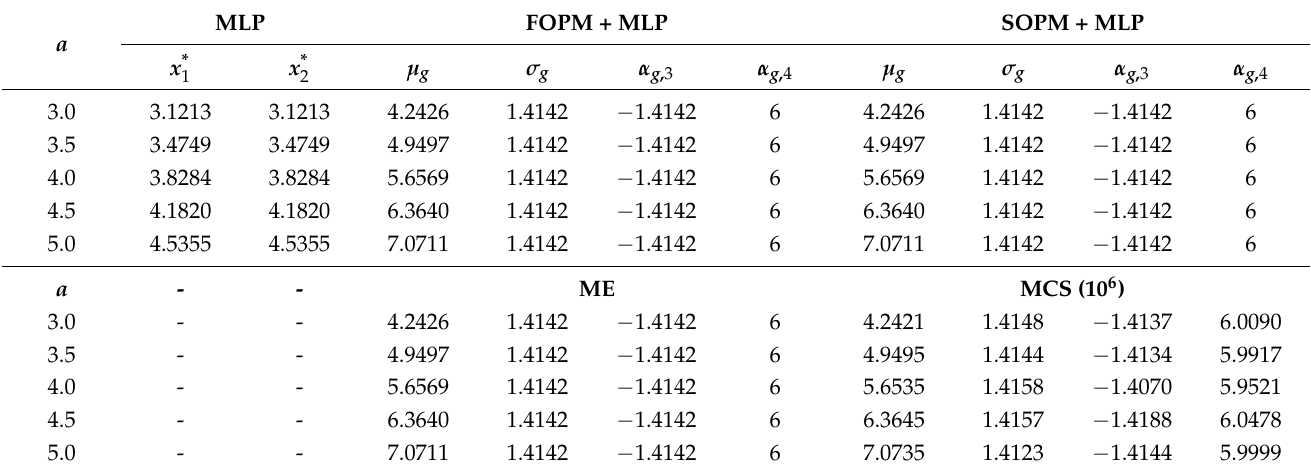
Table 1. MLP and the first four statistical moments calculated by the different methods for Example 1.